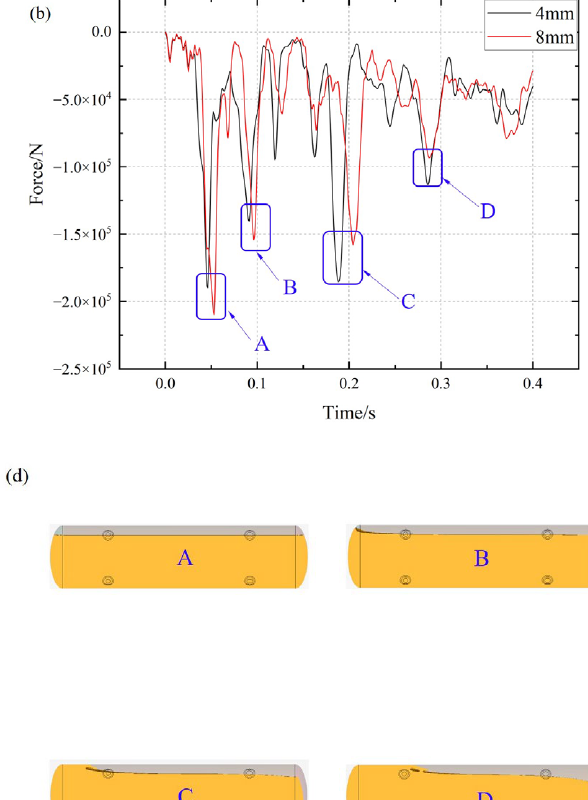
Appl. Sci. 2023 , 13 , 1351